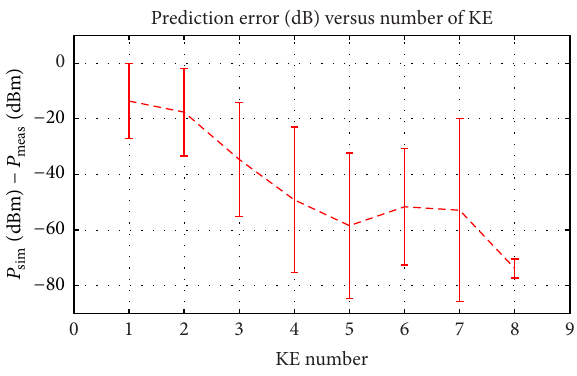
Figure 9: ORT model error [dB] for selected strongly NLOS and “far” Rx